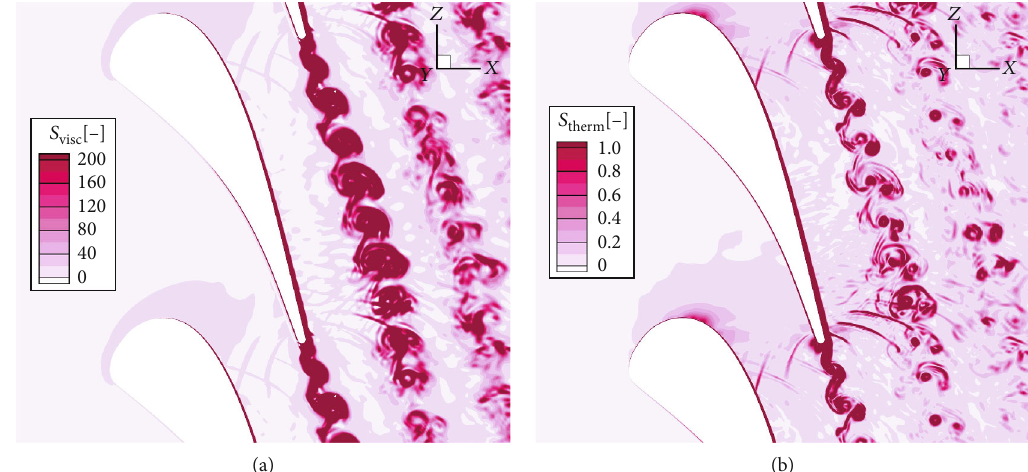
Figure 16: Comparison of local losses due to viscous and heat-transfer e ff ects (MUR129): (a) viscous entropy generation rate; (b) thermal entropy generation rate.